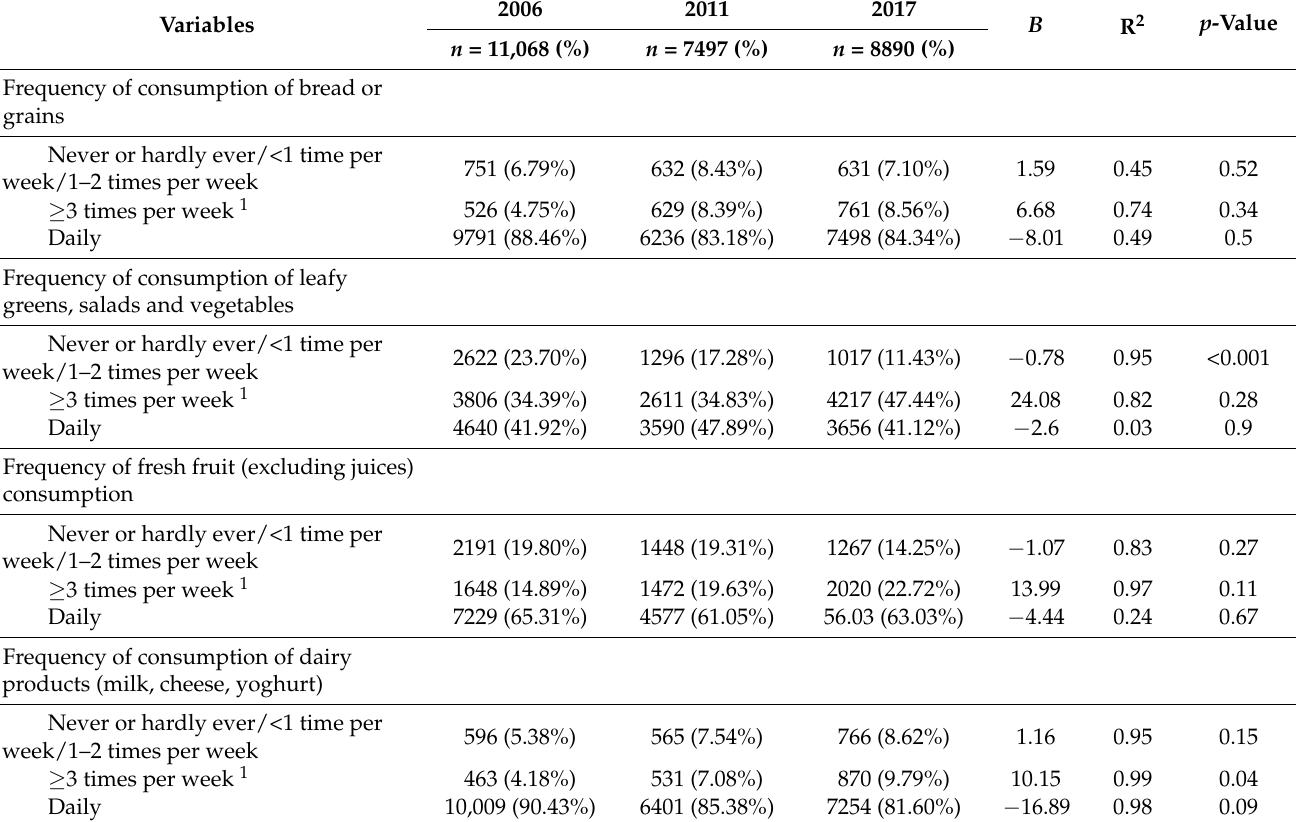
Table 1. Frequency of food consumption in workers aged 16–64 years ( N = 27,455) (2006–2017).